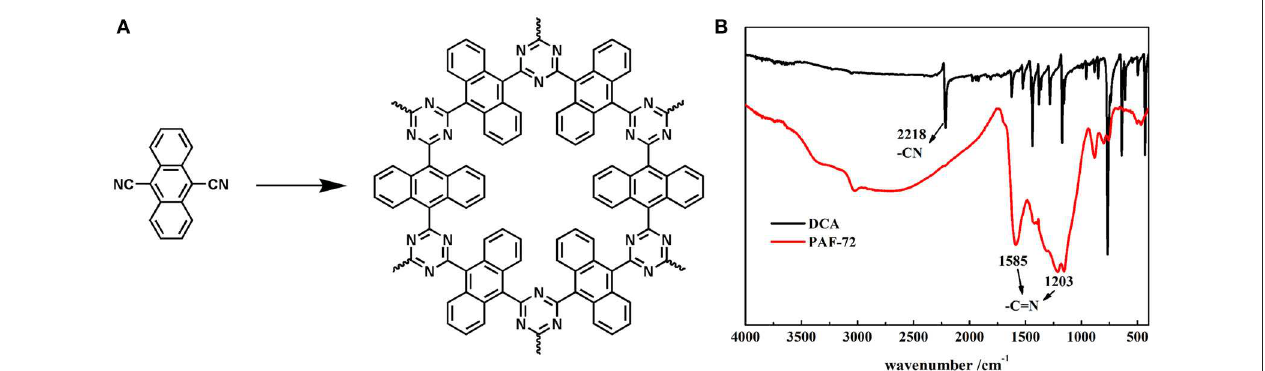
FIGURE 1 | (A) Synthetic route of PAF-72 and (B) FTIR spectra of PAF-72 (red) and DCA